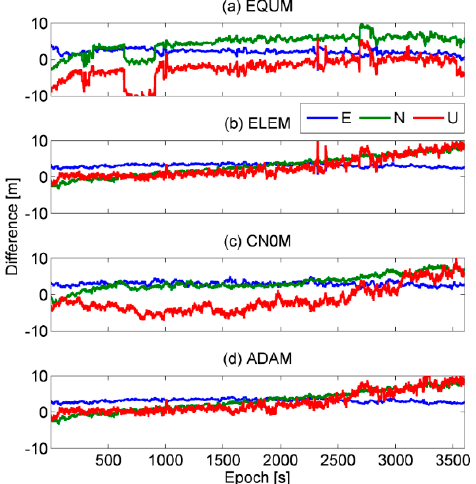
Figure 12. Positioning differences between the SPP solutions and the precise coordinates of dataset no. 2. ( a ) Results of the equal-weight model (EQUM); ( b ) results of the elevation model (ELEM); ( c ) results of the C/N0 model (CN0M); and ( d ) results of the adaptive model